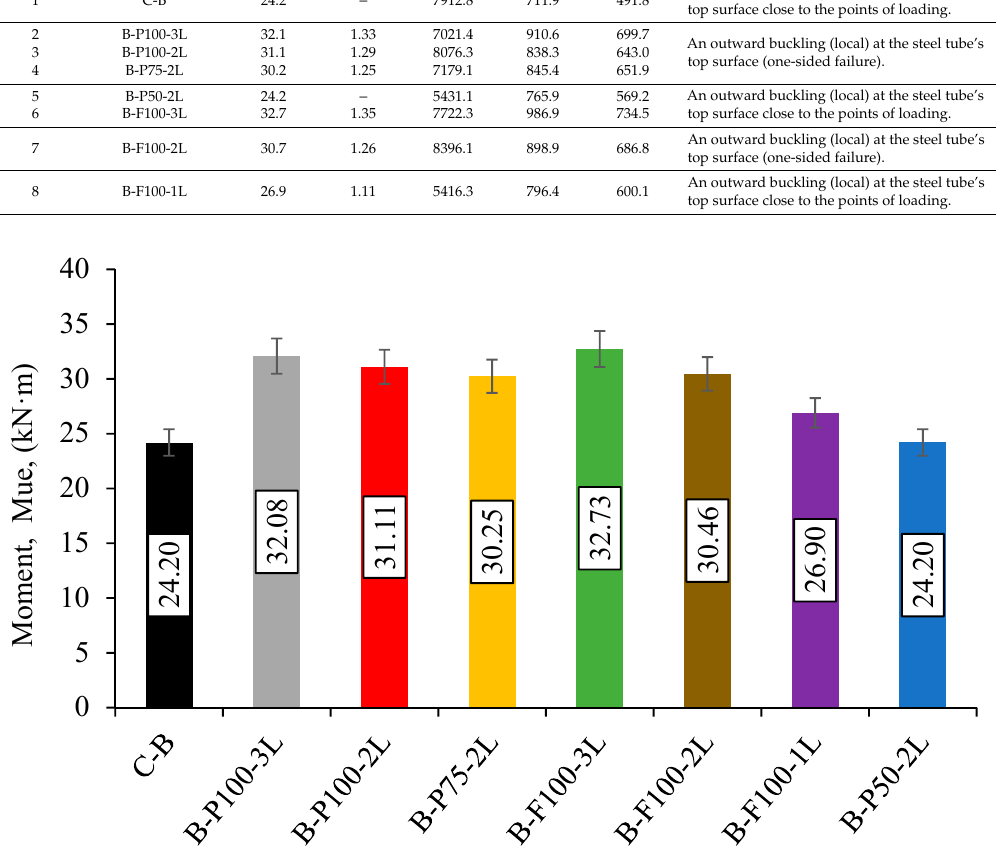
Figure 7. Ultimate moment capacity (M ue ) of beams. Table 5. HPCFDST beams results.